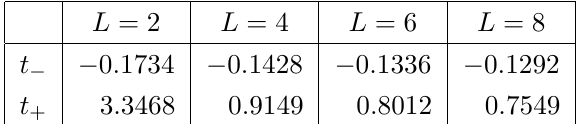
Table 3 . Approximate values of the tachyon coe(cid:14)cients t where Newton’s algorithm stops con- verging for branch 1 at levels ( L; 3 L ) in Siegel